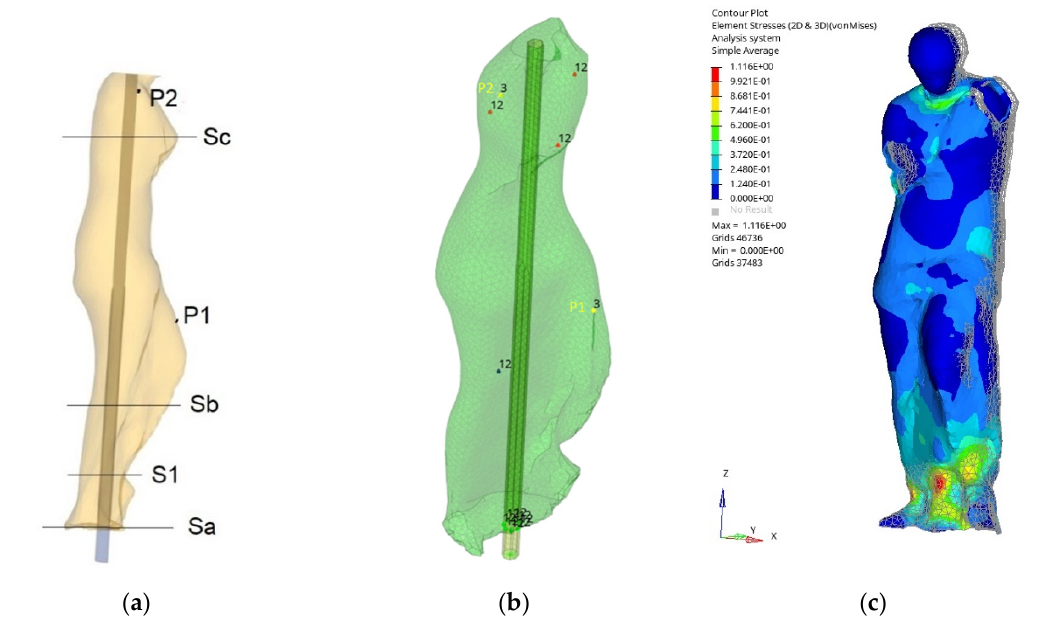
Figure 4. ( a ) Lateral view of DS and central beam NDS; ( b ) Boundary conditions (numbers represent locked DOFs: 1 = DOF locked in x direction, 2 = DOF locked in y, 3 = DOF locked in z). ( c ) von Mises equivalent stress (MPa).